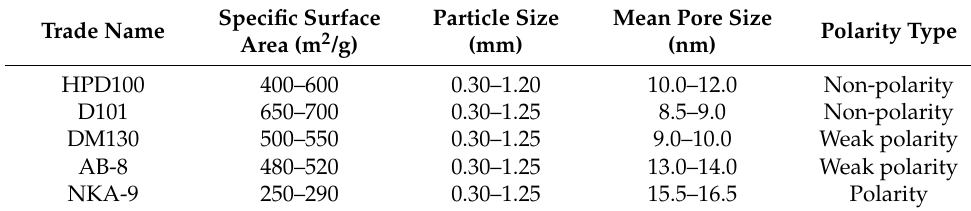
Table 1. Physical properties of the tested resins in this